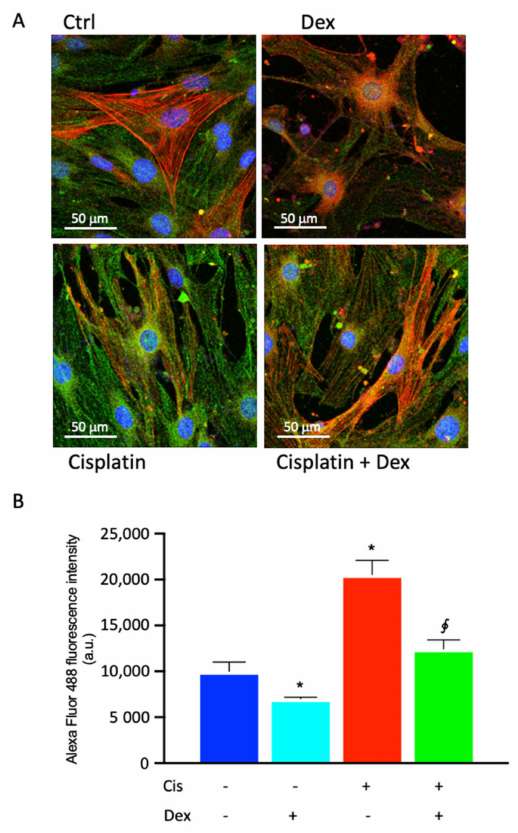
Figure 4. Photomicrographs of COX-2 immunostaining ( A ) of BCP cultures in basal medium, without any treatment (control cells, Ctrl) or in medium containing 30 µ M cisplatin in the absence or in the presence of 10 nM dexamethasone (Dex) for 48 h. ( A ) Representative images of immunocytochemical staining for COX-2 (Alexa Fluor 488, green) and alpha smooth muscle actin ( α -SMA, Alexa Fluor 546, red) are shown. Blue fluorescence indicates DAPI staining of cell nuclei. Magnification: 40 × ; Scale bars: 50 µ m. ( B ) Quantitative analysis of COX-2 emission intensity (a.u.). In panel ( B ), each treatment is represented by a different color: control cells are blue, dexamethasone-treated cells are light blue, cisplatin-treated cells are red and cells treated with cisplatin plus dexamethasone are green. The data are representative of three independent experiments with three parallel samples for each group in each experiment and are expressed as mean ± SD. * p < 0.05 vs. cells without treatment; (cid:72) p < 0.05 vs. cells treated with cisplatin. The non-parametric Mann-Whitney test was used for pairwise